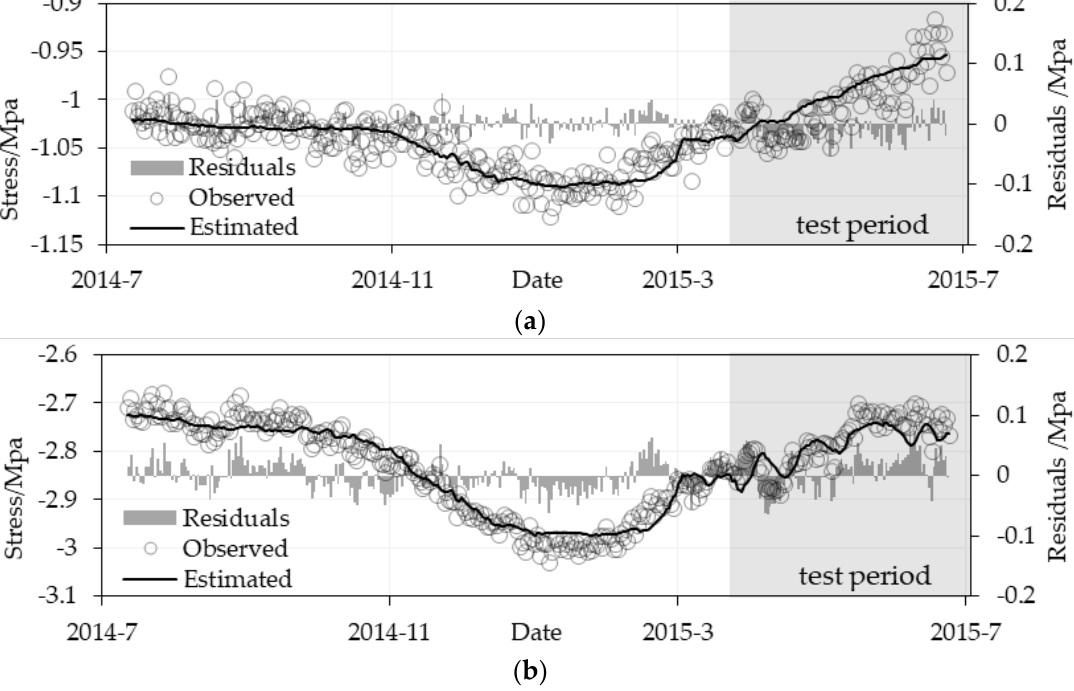
Figure 10. Predictions of the proposed estimation model (lines) versus observed data (circles). The residuals between them are shown in the bar chart. Shaded part is the testing period. ( a ) Direction along the river. ( b ) Vertical direction.